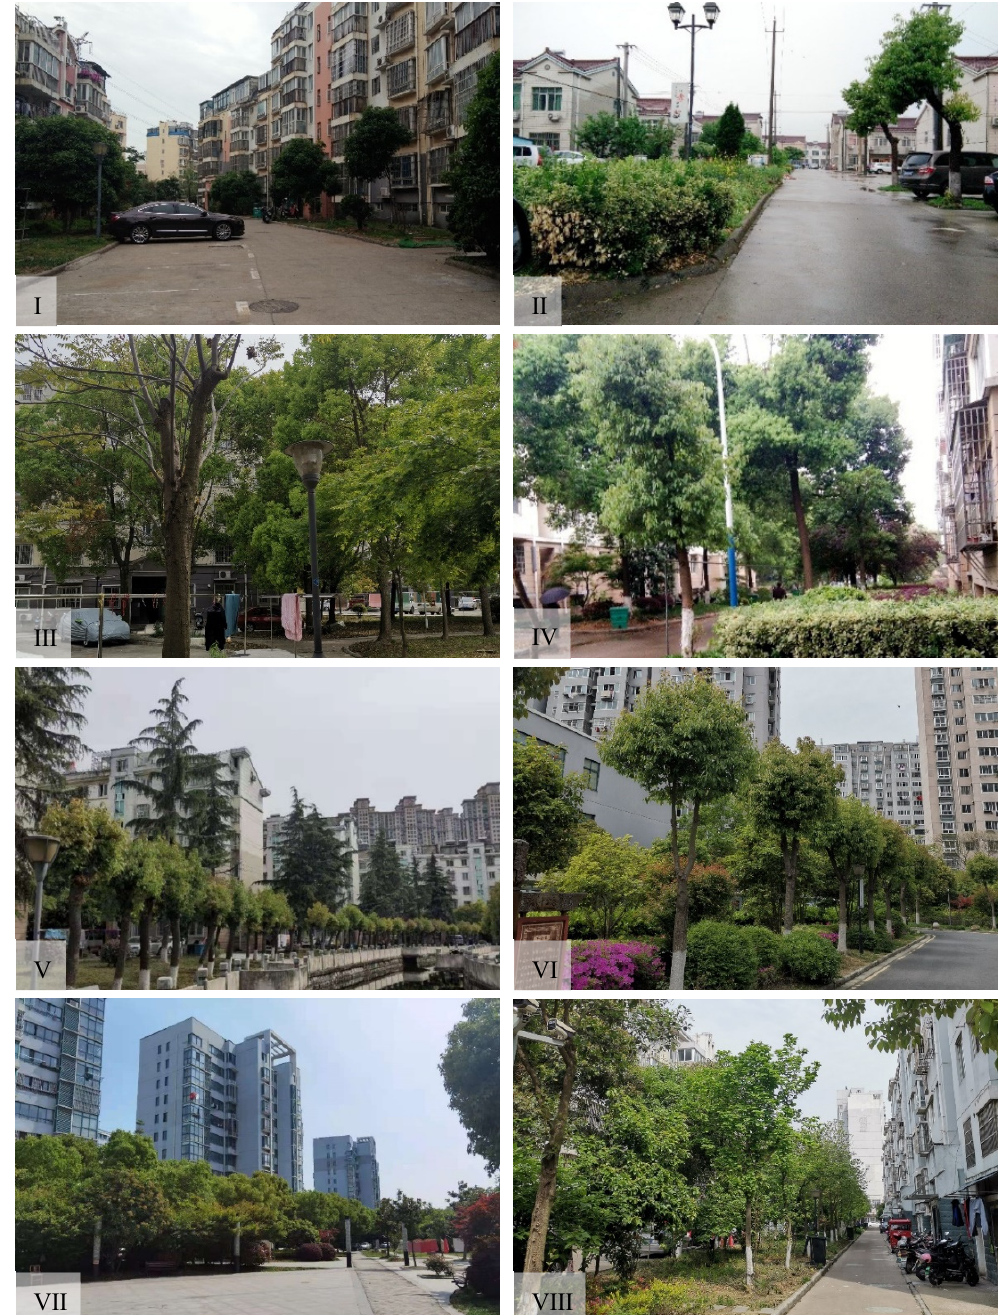
Figure 1. Images of selected resettlement residential areas (RRAs) in Changzhou, including Group A (( I ): Jiangnan Chunxiao; ( II) : Weitang Wucun; ( III ): Taishan Huayuan), Group B (( IV ): Baixin Yuan; ( V ): Qianqiao Xiaoqu; ( VI ): Xinfeng Yuan), and Group C (( VII ): Ziyun Yuan; ( VIII ): Qinglong Yuan).